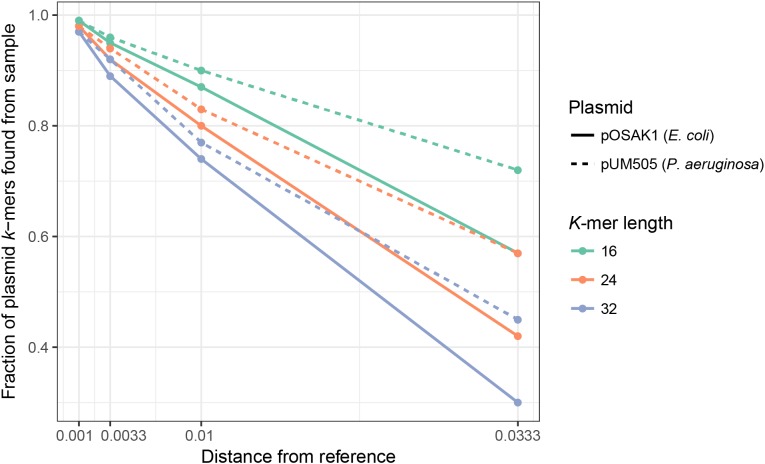
Fraction of detected plasmid k-mers (F) is affected by the distance from the reference plasmid and k-mer length.F decreases with increasing k-mer length, with more pronounced differences with larger distances. In all cases, increasing the distance decreased F. Name, size and bacterial host of the plasmid were as follows: pUM505, 123,322 bp, P. aeruginosa; pOSAK1, 3,306 bp, E. coli. Green lines show test results for k = 16, orange line k = 24 and blue line k = 32. Distance from the reference plasmid is given in nucleotide substitutions per bp.